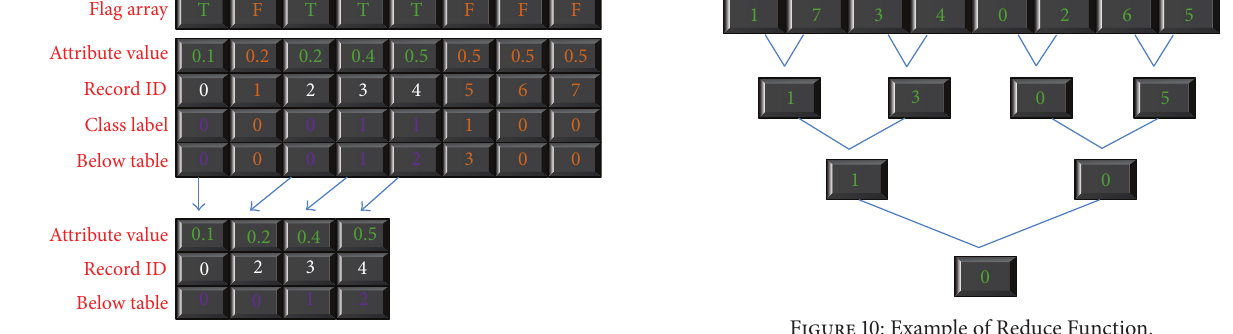
Figure 9: Example of compact function.